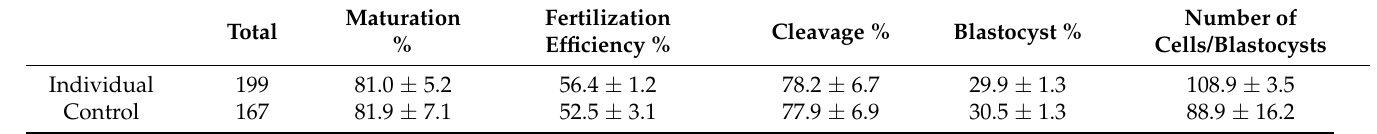
Table 2. Mean values of individual and group (control) IVC parameters.